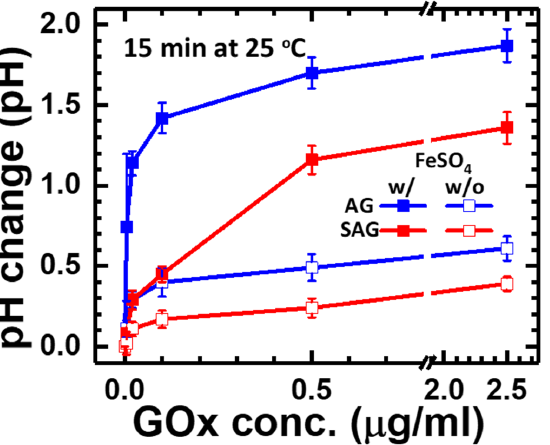
Figure 4. Endpoint pH change with different concentrations of avidin-conjugated or streptavidin- conjugated GOx and adding FeSO 4 solution after 15 min of reaction in part #2.